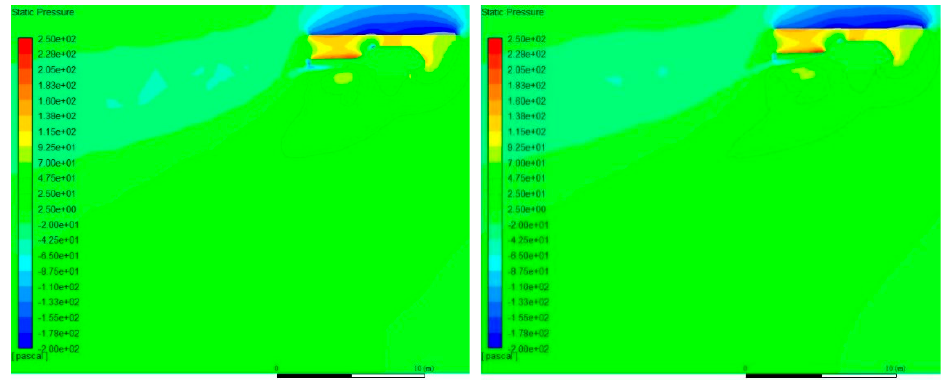
Figure 7. Pressure distributions on a longitudinal symmetry cross section of the initial scenario calculated with fine meshes (the ground is at the ruler in the figure, the left picture is the basic mesh, and the right picture is the fine mesh).